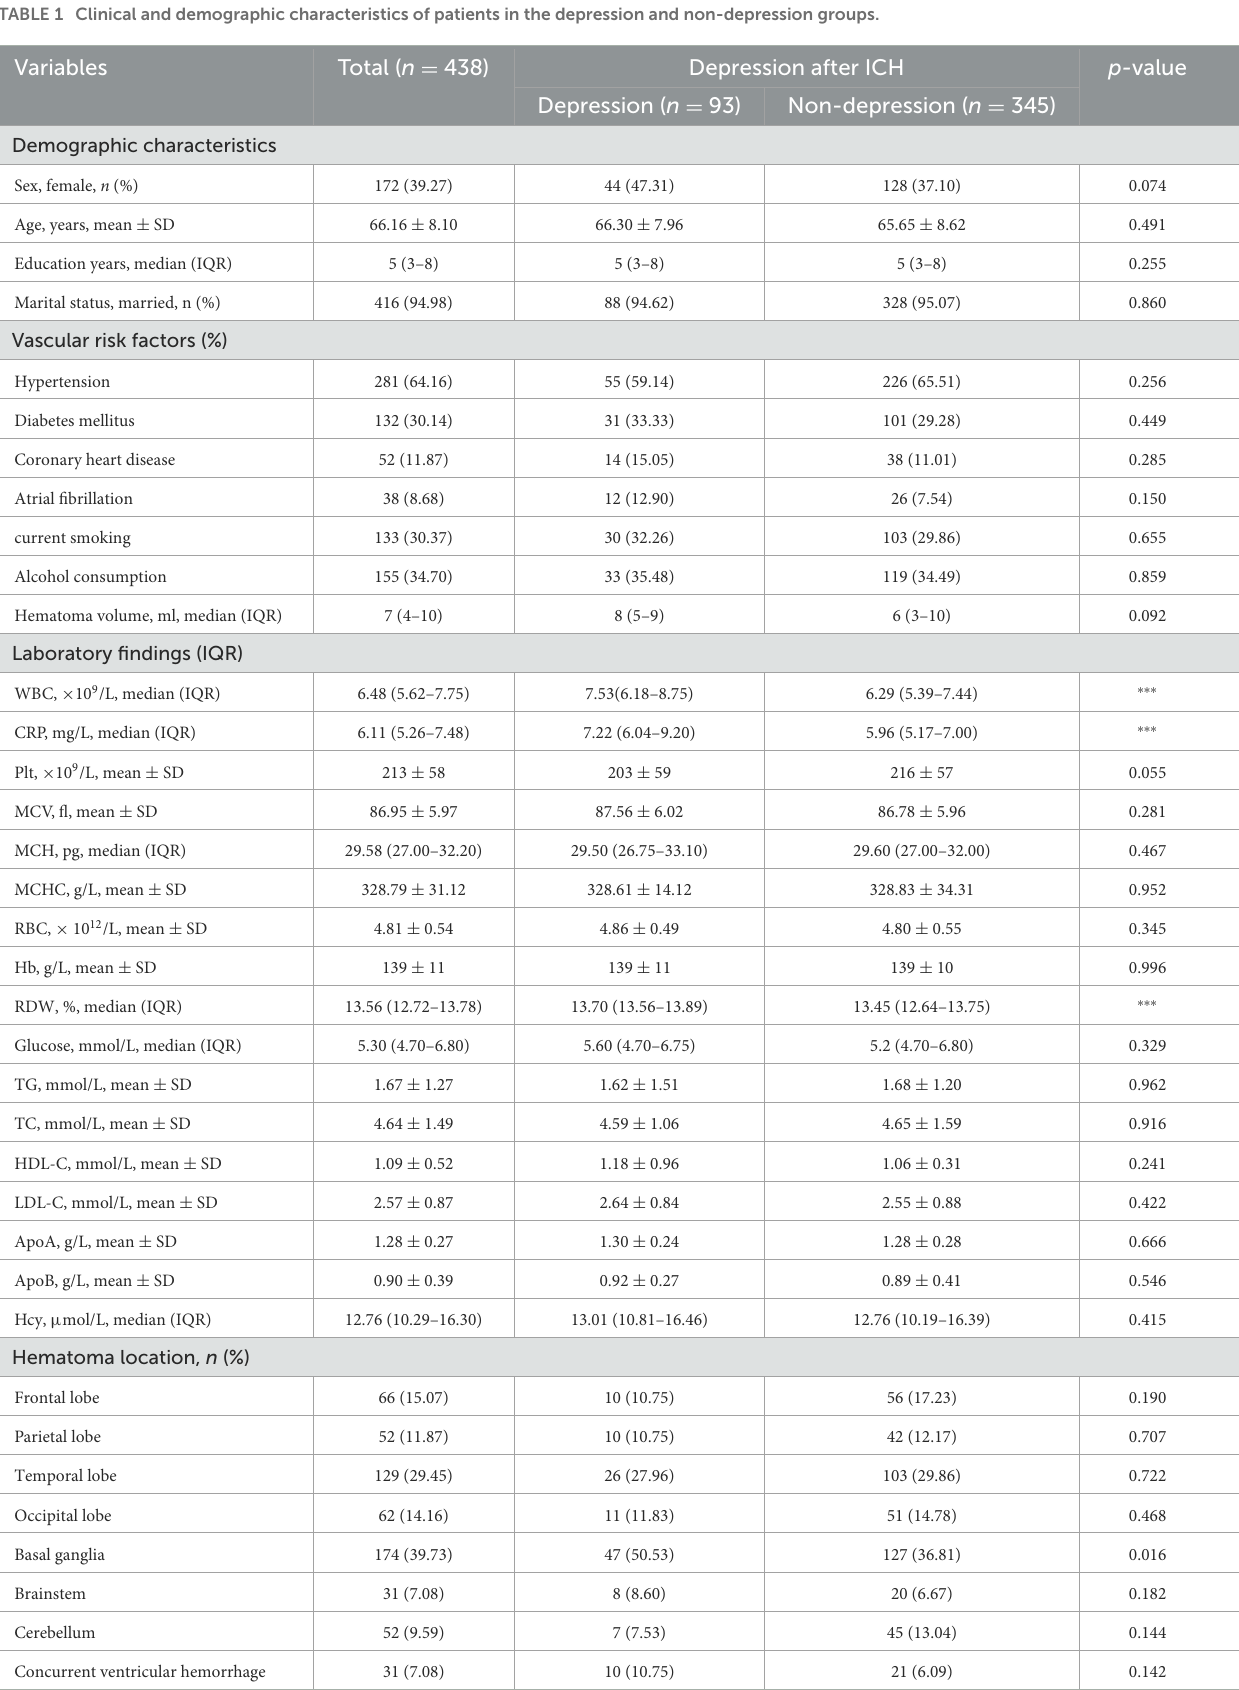
TABLE 1 Clinical and demographic characteristics of patients in the depression and non-depression groups. Variables Total ( n = 438) Depression after ICH p- value Depression ( n =